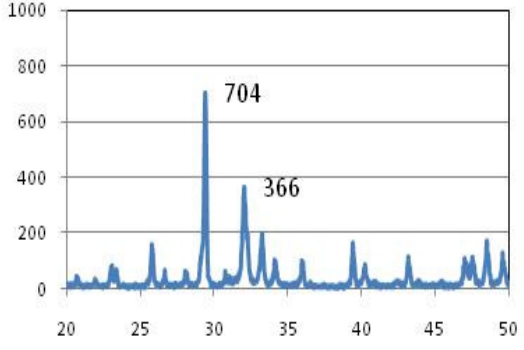
Fig. 1. XRD Spectra of raw Akashat phosphate Ore size 300 micron.